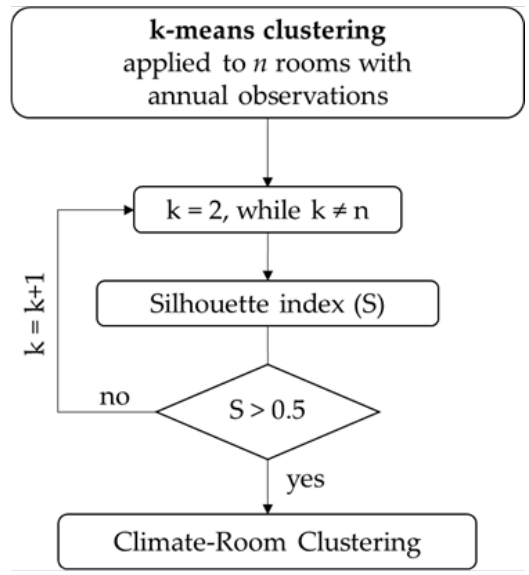
Figure 4. Schematic workflow of the k-means clustering.